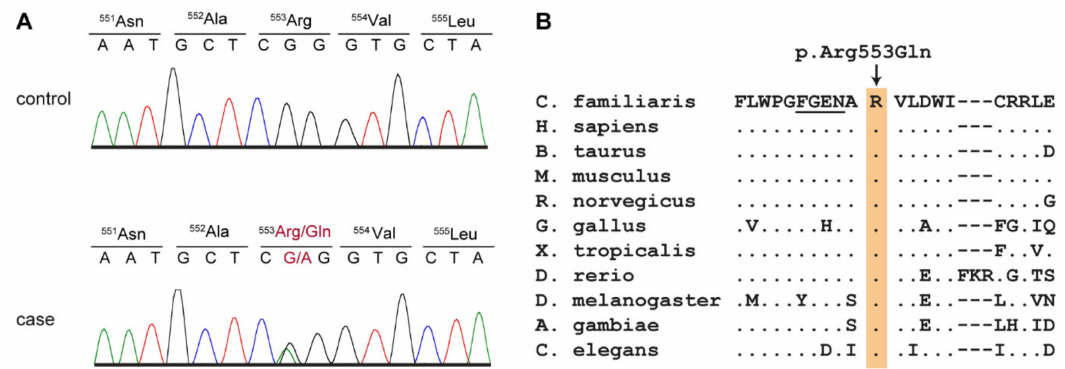
Figure4. DetailsofthePCK2:c.1658G > Avariant. ( A )RepresentativeSangersequencingelectropherograms of two dogs with the different genotypes are shown. ( B ) Evolutionary conservation of the arginine residue at position 553 of the PCK2 protein. A multiple species alignment illustrates that this residue is strictly conserved across animals from worms to mammals. Amino acids 548-551 form part of the GTP-binding site of PCK2 and are underlined [31].